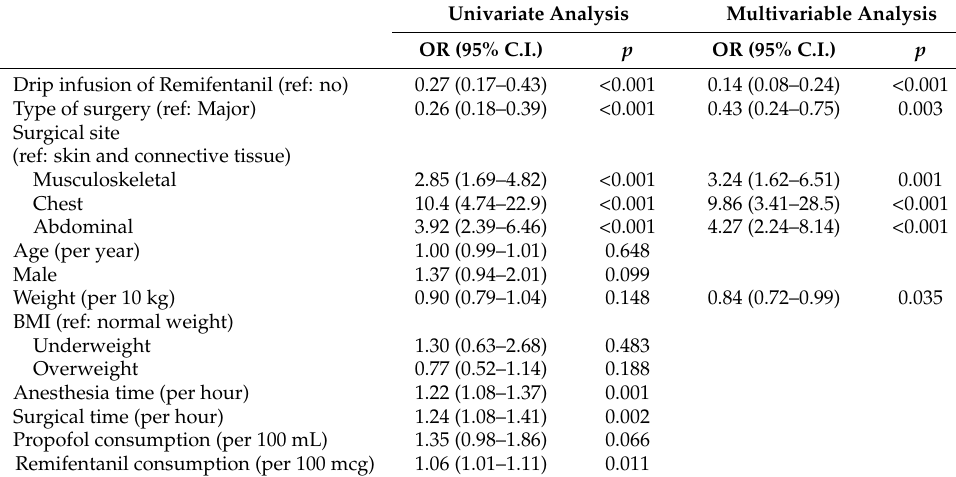
Table 4. Logistic regression analysis demonstrating factors associated with use of rescue analgesics (ref: no use). Univariate Analysis Multivariable Analysis OR (95% C.I.) p OR (95%